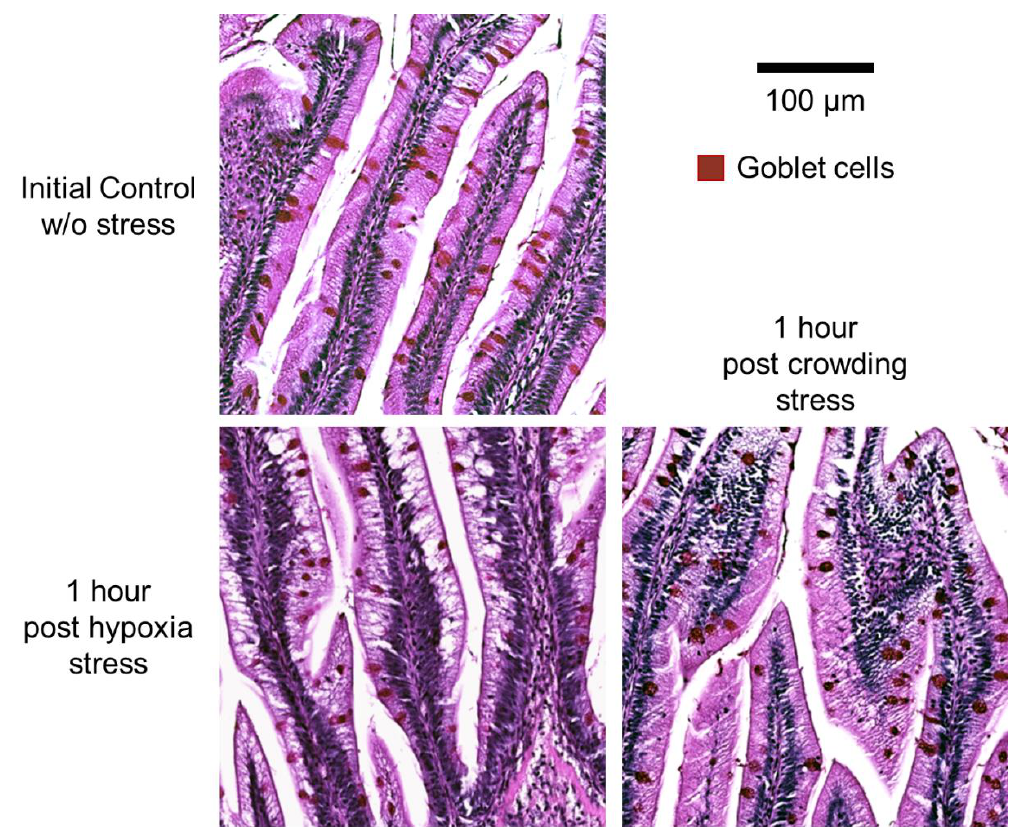
Figure 4 . Histology of Periodic acid–Schiff (PAS)-stained tissue sections of distal intestine from Atlantic salmon. Top left panel: initial control group. Lower left panel: 1 h post-hypoxia stress. Lower right panel: 1 h post-crowding stress. In red-brown: PAS+ goblet cells. Bar: 100 µm.